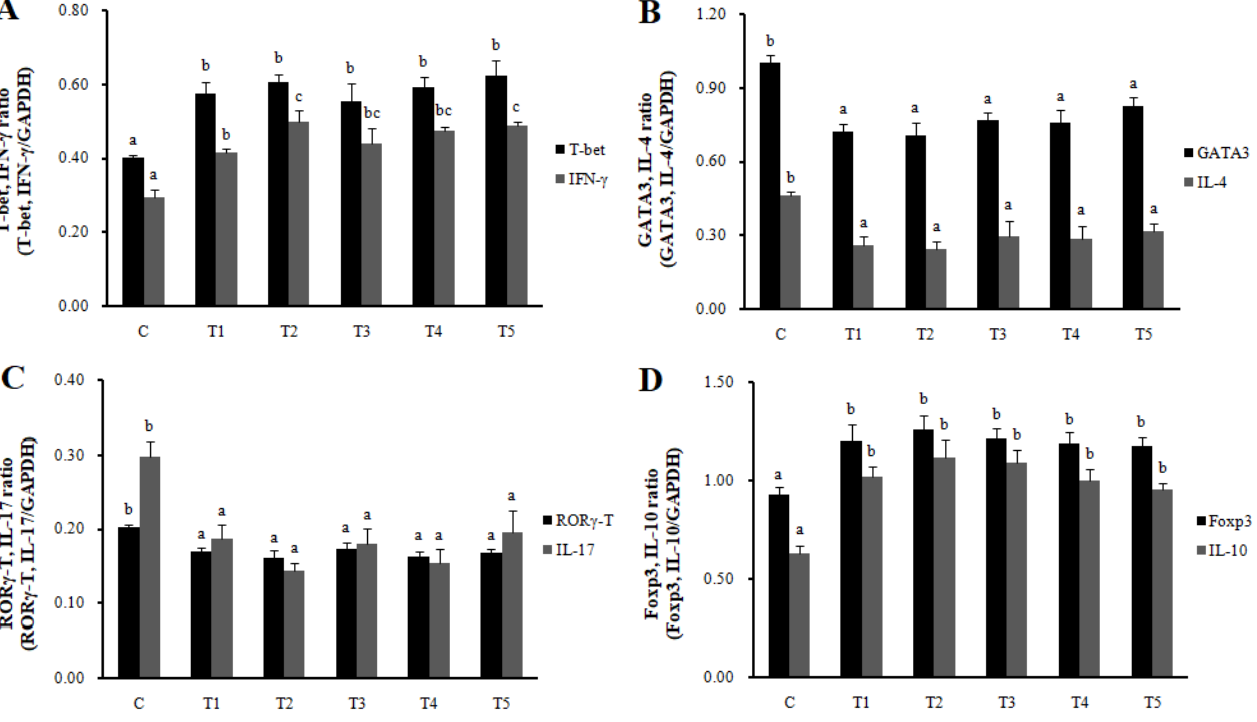
Figure 2. Th1, Th2, Th17, and Treg cells transcription factors and cytokines expression in MLN by real-time reverse transcriptase polymerase chain reaction analysis. T-bet, IFN-γ (Th1, A), GATA-3, IL-4 (Th2, B), RORγT, IL-17 (Th17, C), and Foxp3, IL-10 (Treg, D). Data represent means± - standard deviations of 8 replicates. RC -LAB, Rubus coreanus -derived lactic acid bacteria; T-bet, T-box expressed in T cells; GATA 3, GATA binding protein 3; RORγT, RAR-related orphan receptor gamma T; Foxp3, forkhead box P3; IFN-γ, interferon-gamma; IL-4, interleukin-4; C, control; T1, 1% RC -LAB fermented feed; T2, 2% RC -LAB fermented feed; T3, 2% L. plantarum ; T4, 2% L. acidophilus ; T5, 2% B. animalis . a-c Means are significantly different within the same row